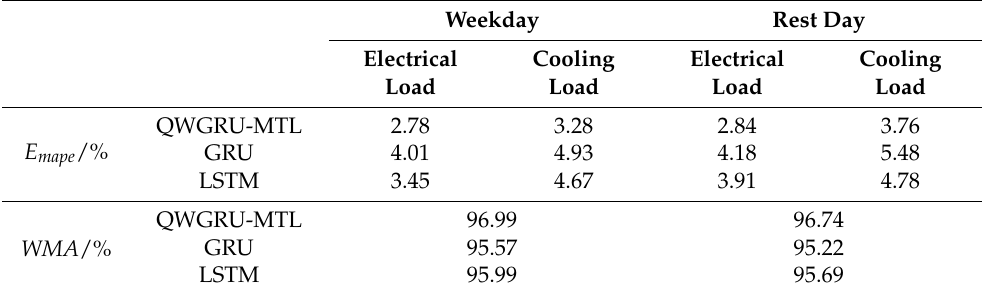
Table 2. Prediction effects of the three